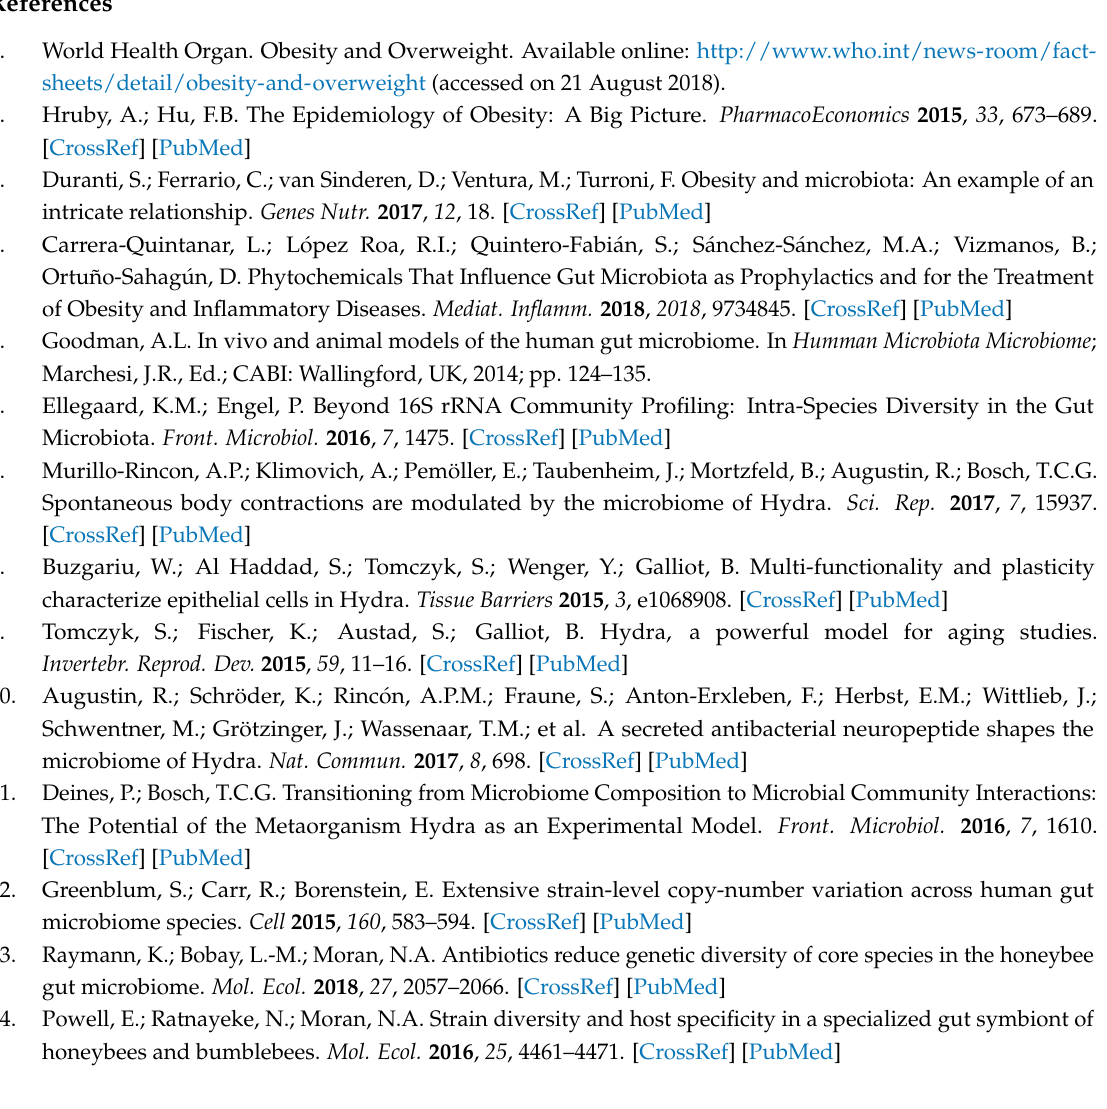
s1, Figure S1: Flow diagram of search strategy and selection